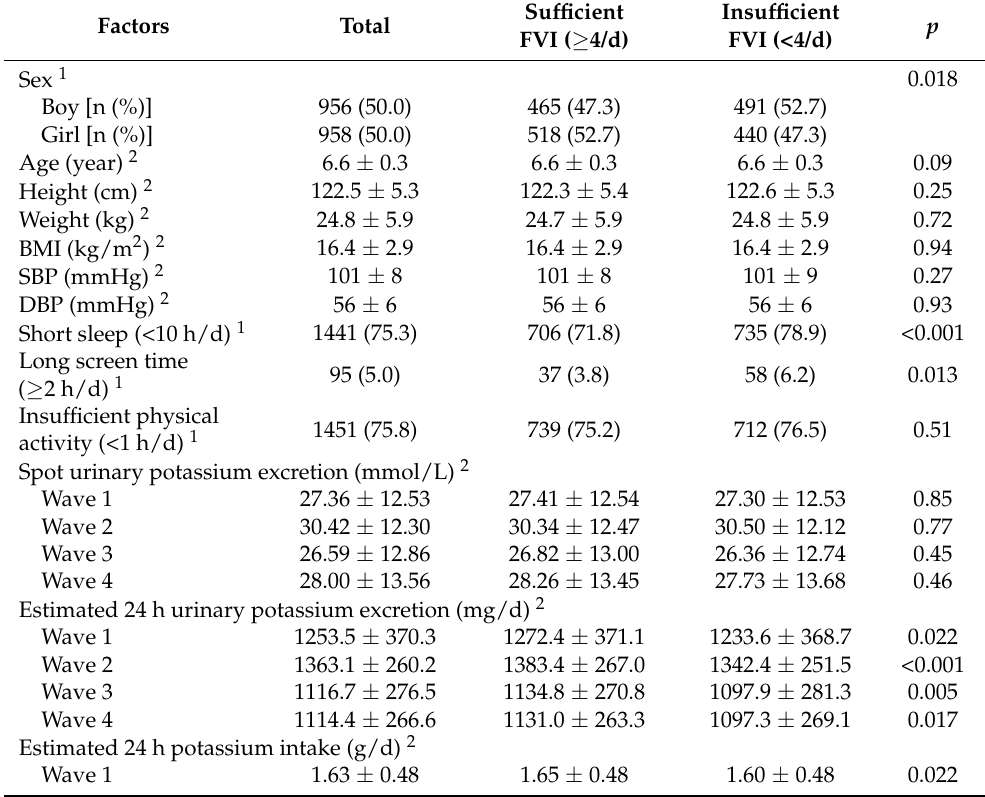
Table 1. Descriptive characteristics of 6–9 year old children categorized by sufficiency of fruit and vegetable intake or not in Beijing, China ( N =